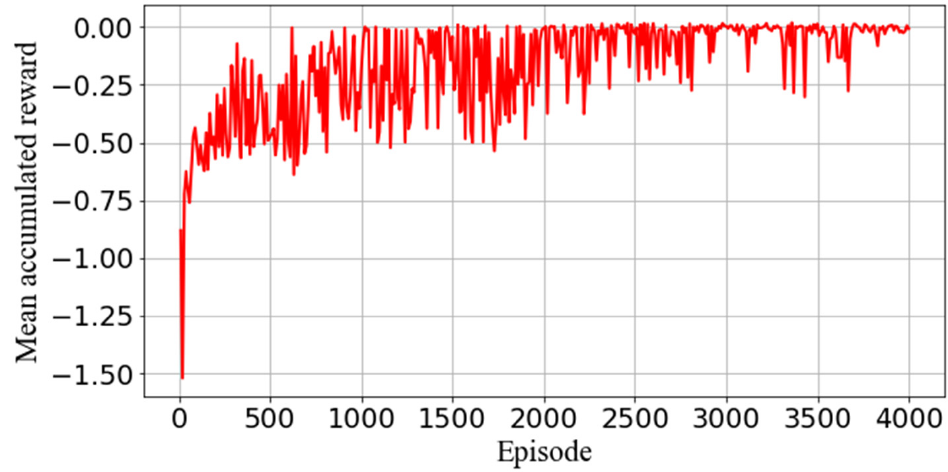
Figure 3. Average accumulated reward in the total training phase.